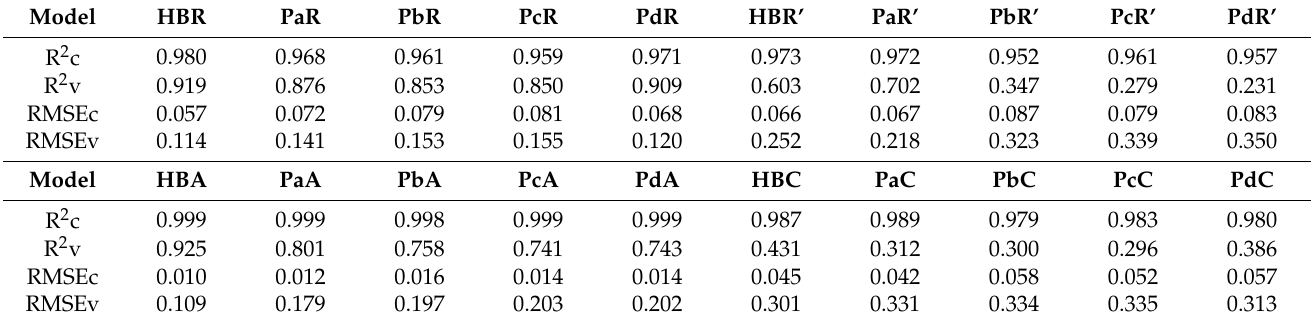
As explained in detail in Table 2, the model names in Table 6 correspond to: JLB: Jilin Benchmark (0.075 mm particle size); a, b, c and d in model names refer to particle sizes of 0.1, 0.25, 0.5, and 1 mm, respectively; R, R’, A, and C in model names refer to the four forms of spectra.